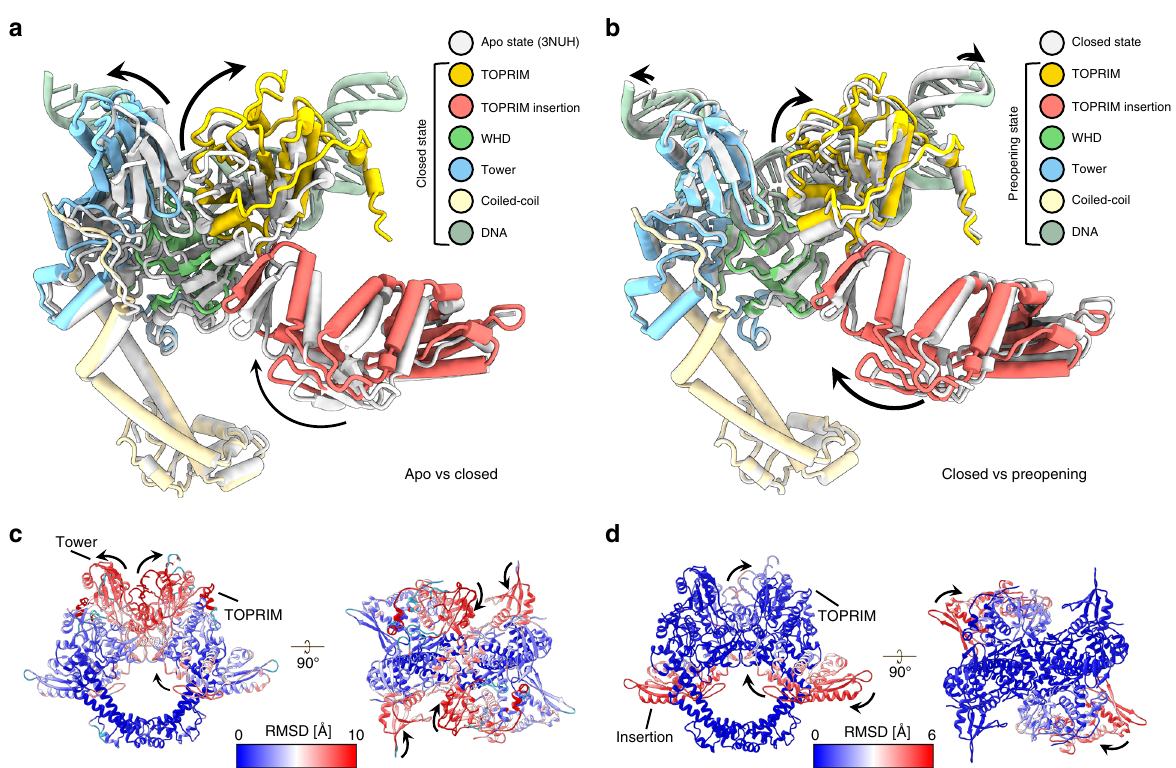
Fig. 5 Conformational changes associated with G-segment binding, cleavage and opening. a Superimposition of the cleavage complex in a closed state (this study) to the DNA-free DNA-binding/cleavage domain ( apo state, PDB ID 3NUH). Only one monomer of GyrB and GyrA is displayed for clarity. The superimposition shows that the majority of the movements are performed by the TOPRIM and Tower domains upon DNA binding and cleavage. b Superimposition of the cleavage complex in the pre-opening state to the closed state. The superimposition shows the upward movement of the TOPRIM domain while the tower domain remains fi xed. The TOPRIM insertion domain pivots around the N-terminal GyrA arm preceding opening of the G-segment after cleavage. c RMSD analysis of the DNA-binding/cleavage domain in apo state and cleavage complex in closed conformation. d RMSD analysis of